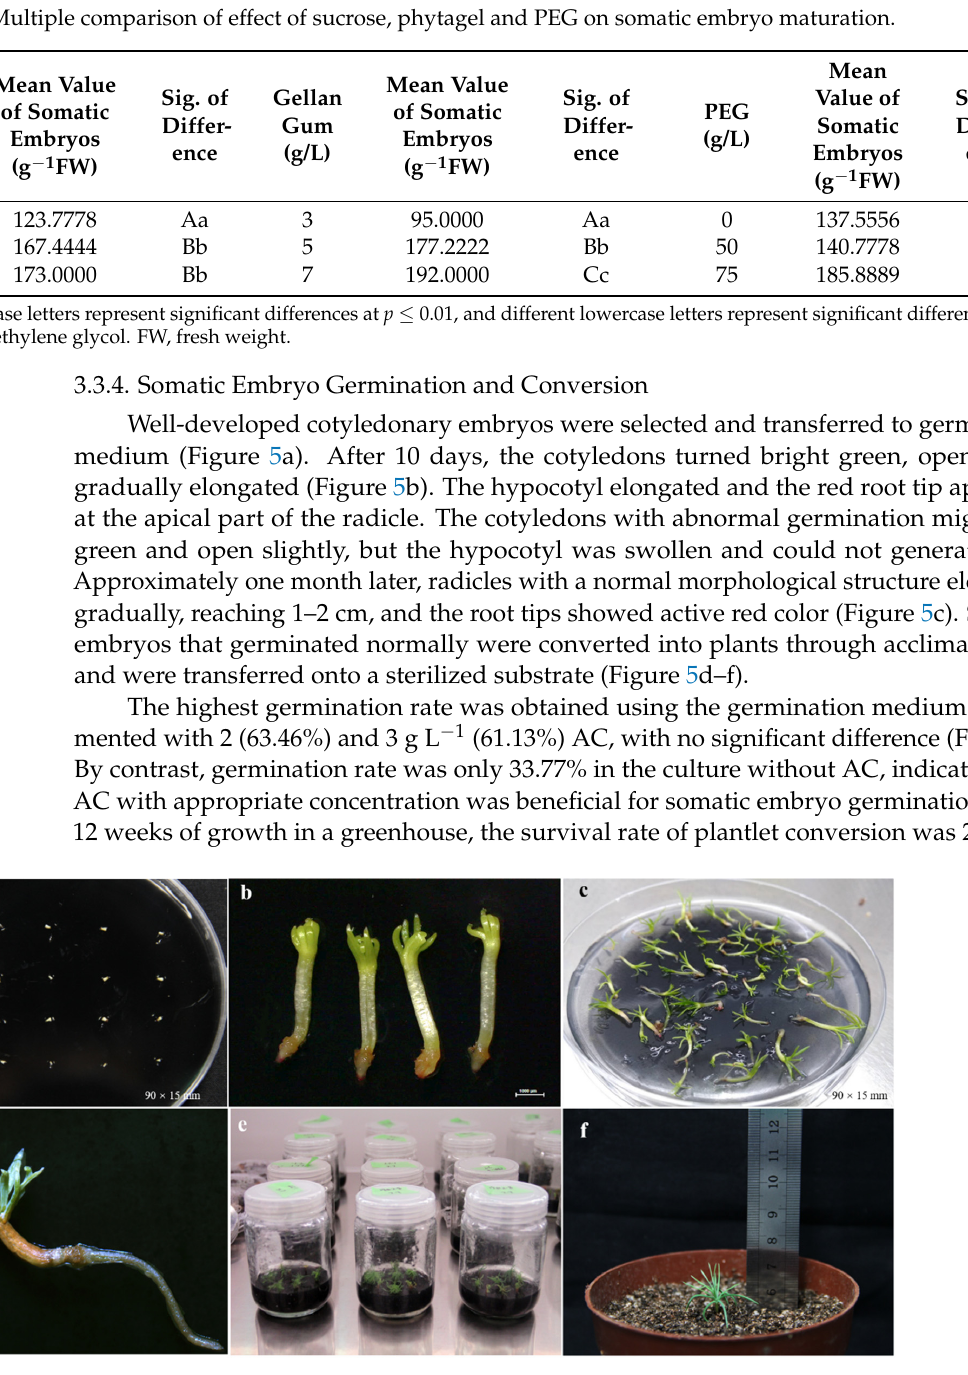
Figure 5. Somatic embryo germination and plant conversion in L. principis-rupprechtii Mayr. ( a – c ) Germination. ( d – f ) Conversion. Bars a, c = 90 × 15 mm, b, d = 1000 µm.